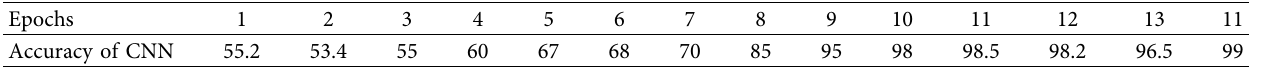
Table 5: Epochs and accuracy of CNN.